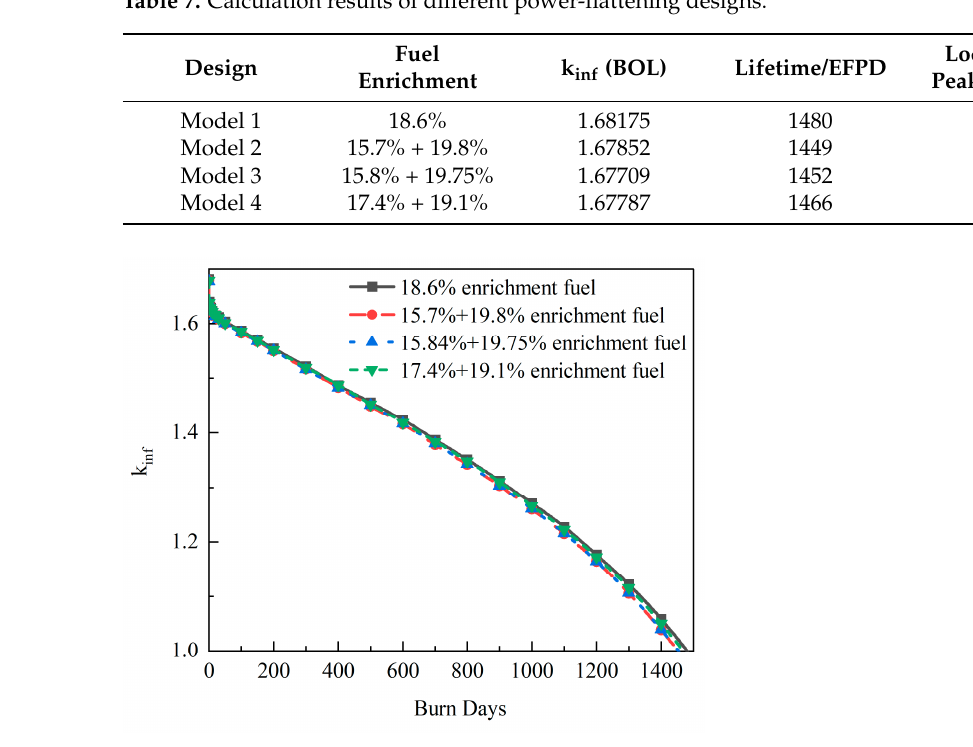
Figure 11. Fuel burnup characteristics at different fuel rod diameters. Table 7. Calculation results of different power-flattening designs.